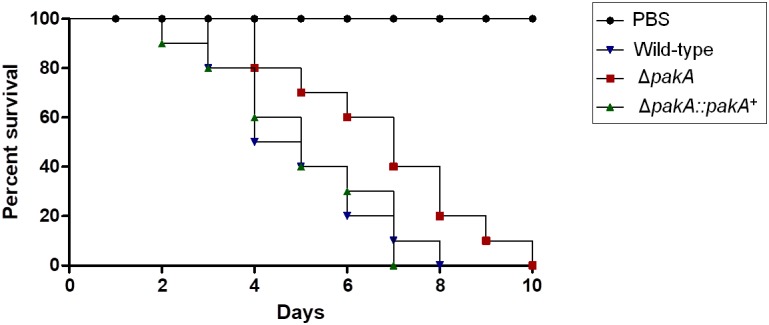
Aspergillus
fumigatus PakA contributes to virulence in G. mellonella. Comparative analysis of wild-type and mutant strains in G. mellonella animal model. Larvae in groups of 10 per strain were infected with a 5 μl suspension of conidia at a dose of 1 × 106/larva. PBS, phosphate buffer saline.